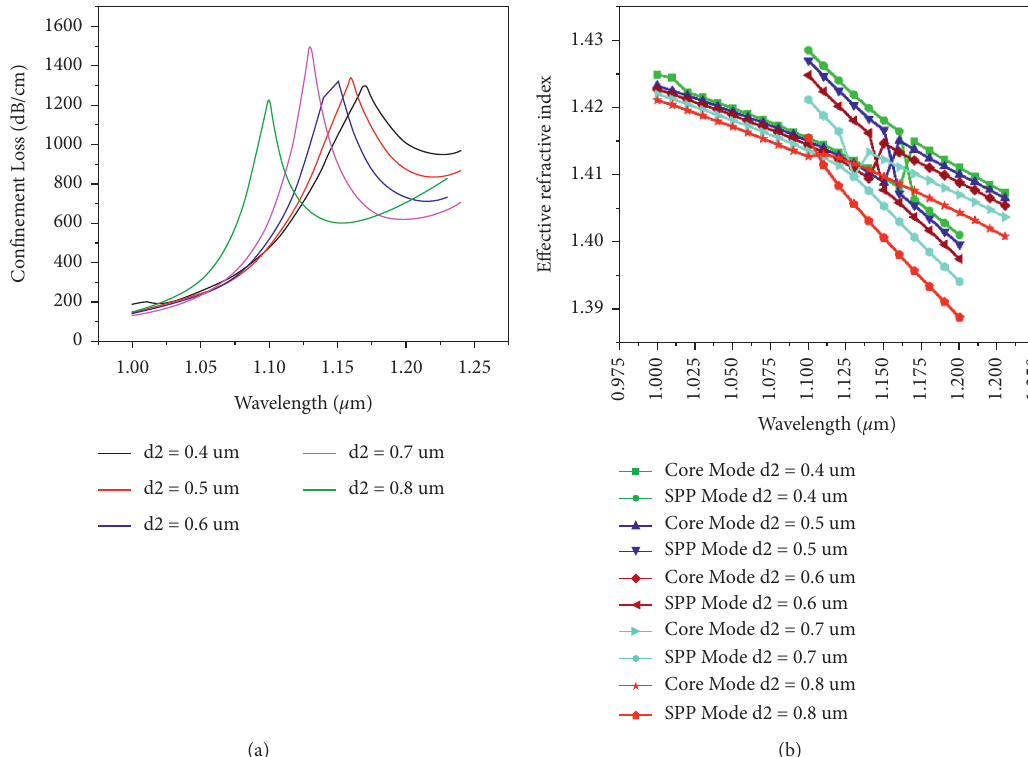
Figure 3: (a) The loss spectra and (b) the effective mode index with varying d